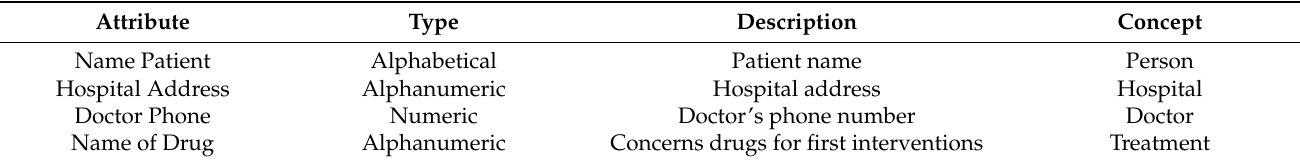
Table 3. Examples of concept attributes.